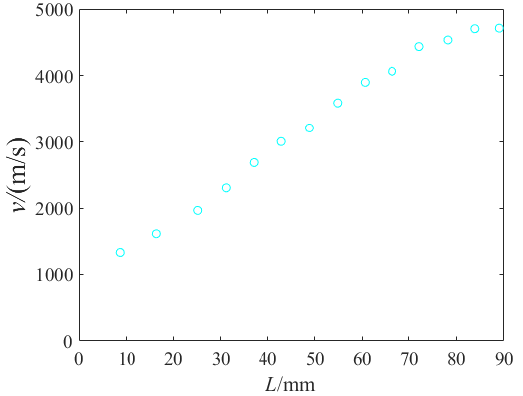
Figure 6. Jet velocity distribution.